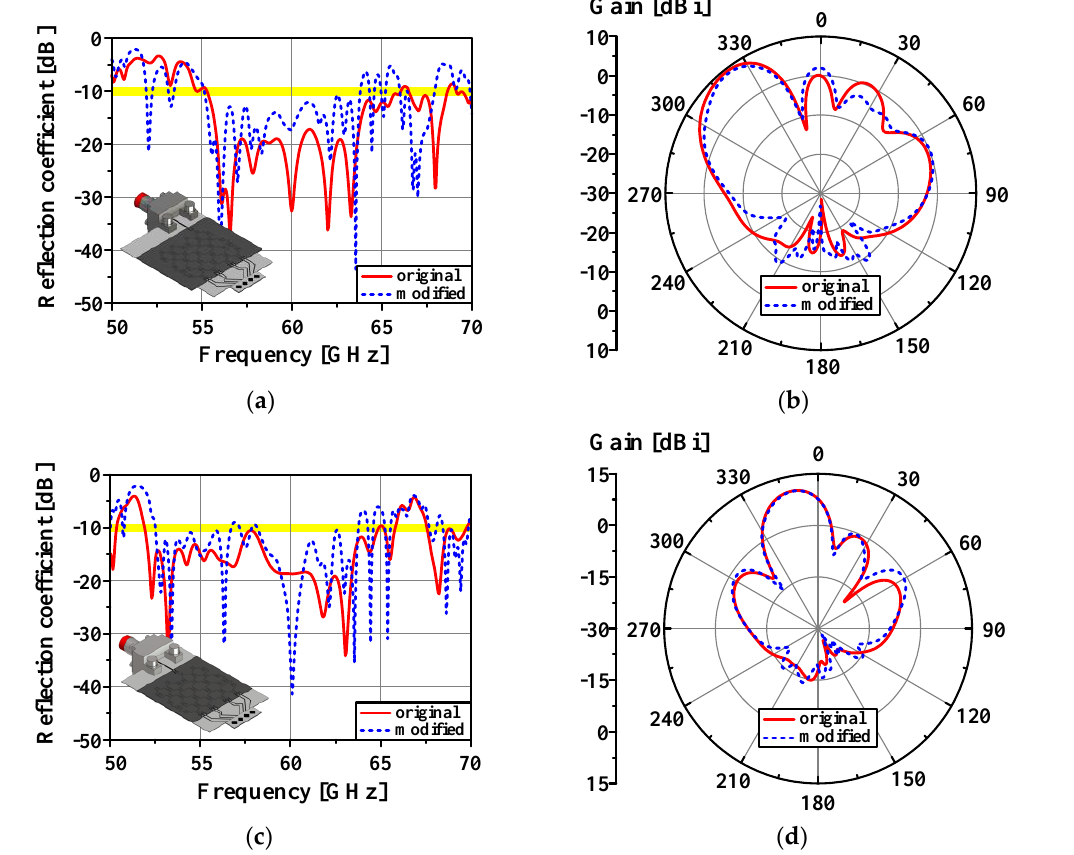
Figure 15. Comparison of the simulated results between the original model and modified model: ( a ) reflection coefficient for port 2 model, ( b ) radiation pattern for port 2 model, ( c ) reflection coefficient for port 4 model, and ( d ) radiation pattern for port 4 model.